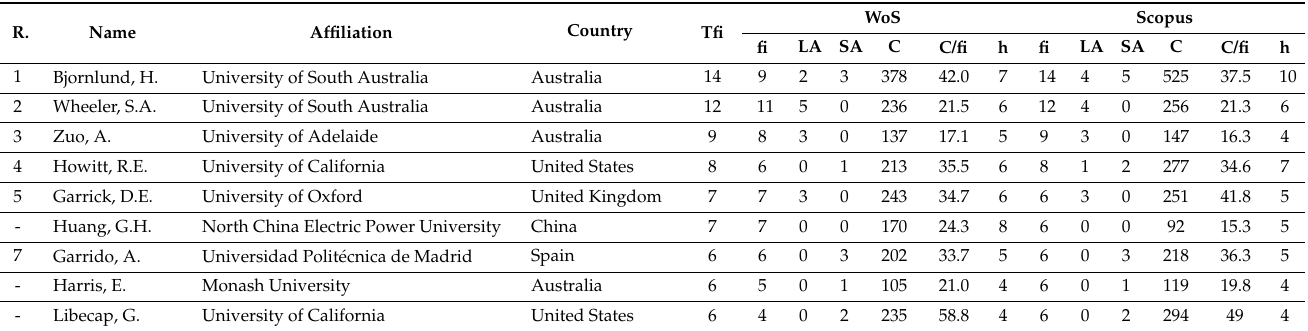
Table 8. Ranking of the most productive authors in the Water Market area in WoS and Scopus with more than five authors.